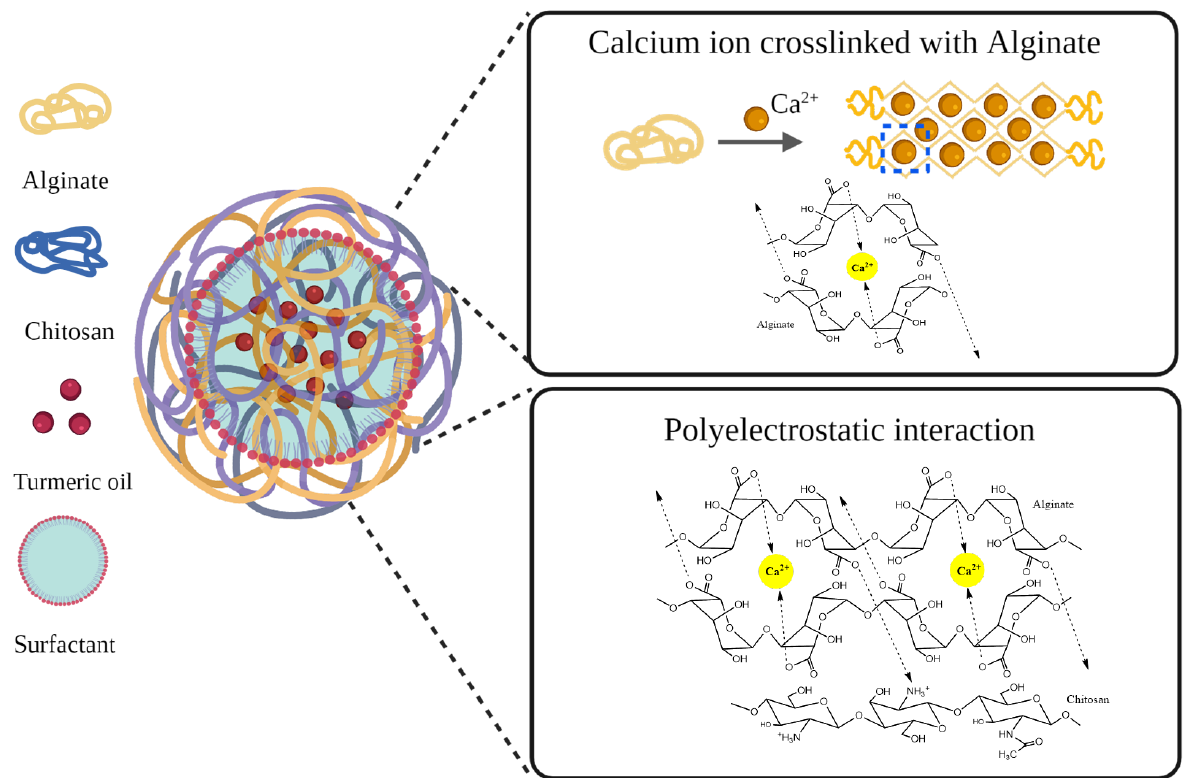
Figure 1. Electrostatic interaction of the anionic Alg with Ca + ions and cationic CS polymer.